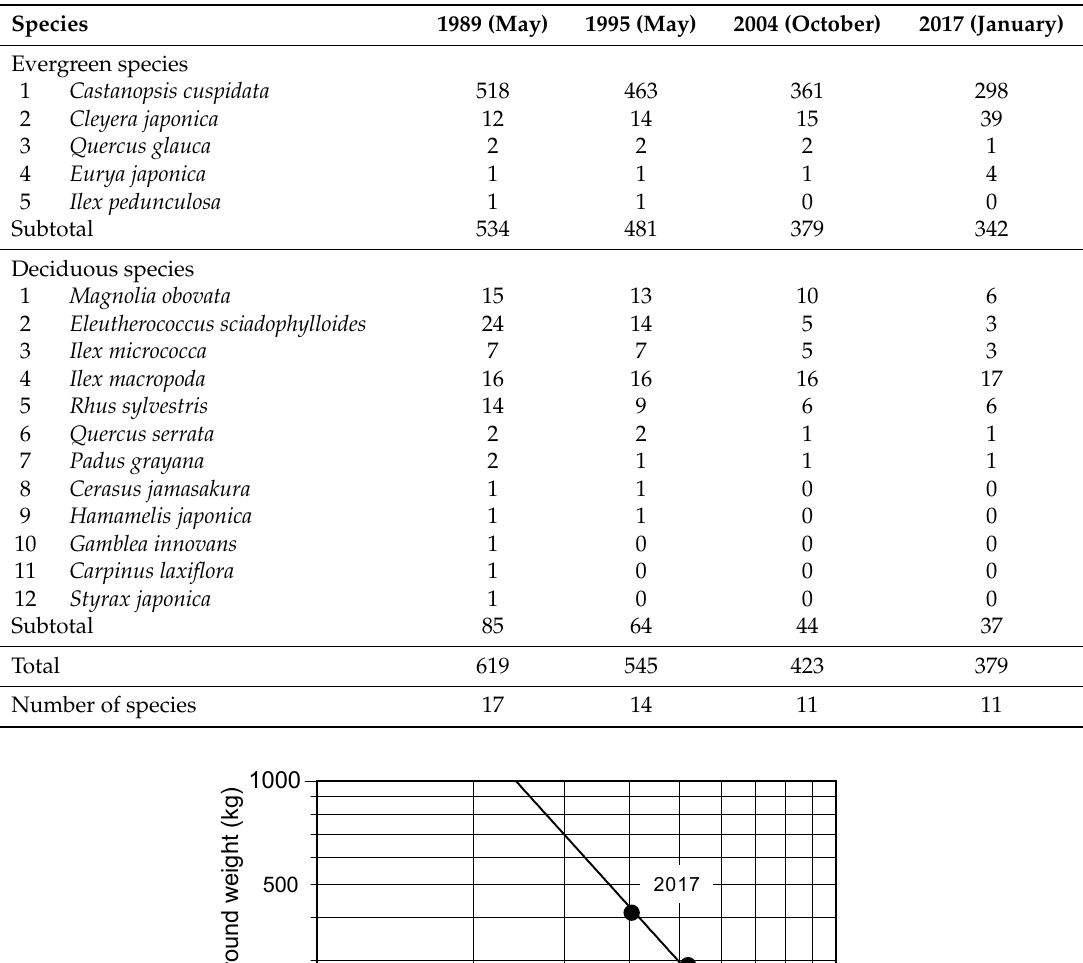
Table 3. Dynamics of species and stems number in the permanent plot (0.7 ha) during the 28-year period (DBH ≥ 10 cm).